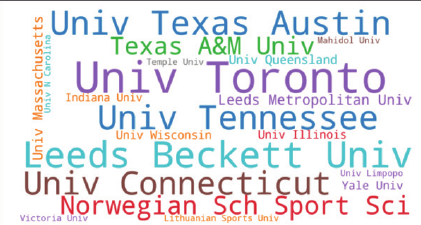
Figure 4. Top institution